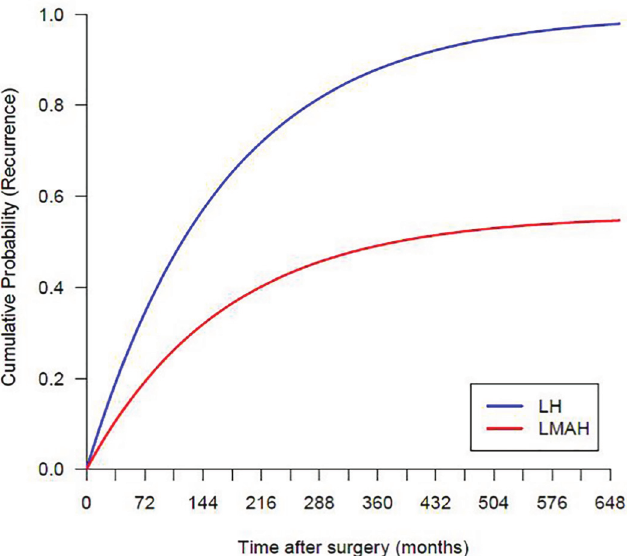
Fig 2. Cumulative probabilities of hiatal hernia recurrence calculated for the Markov Monte Carlo decision-analytic